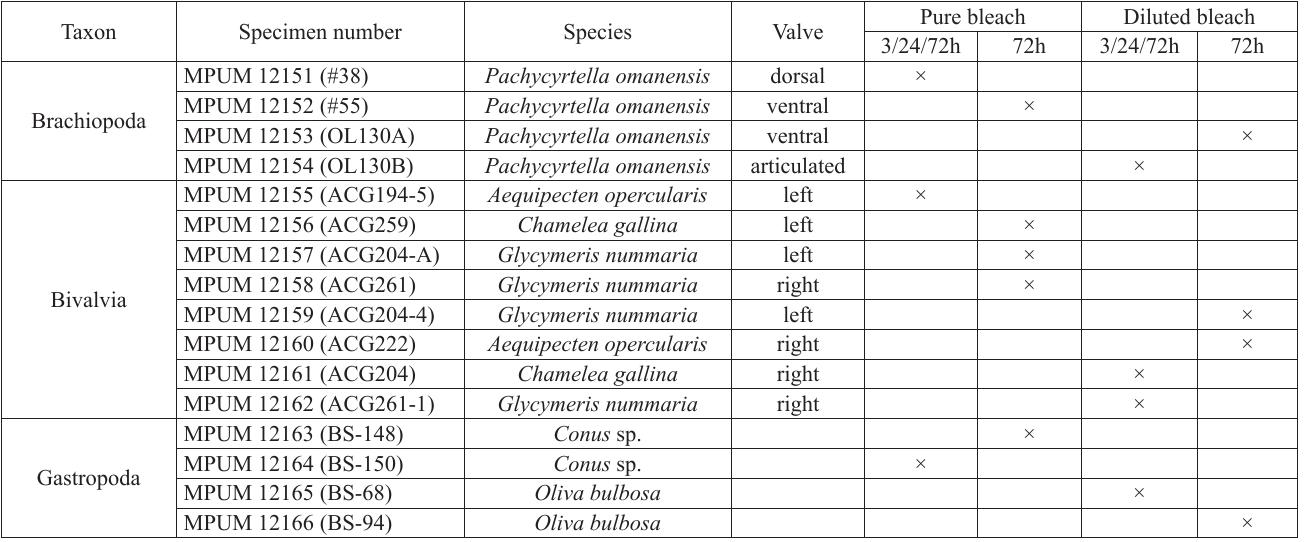
Table 3. Collection numbers, species and valve analysed, and treatment type experienced by the specimens of brachiopods, bivalves, and gastro- pods here investigated.